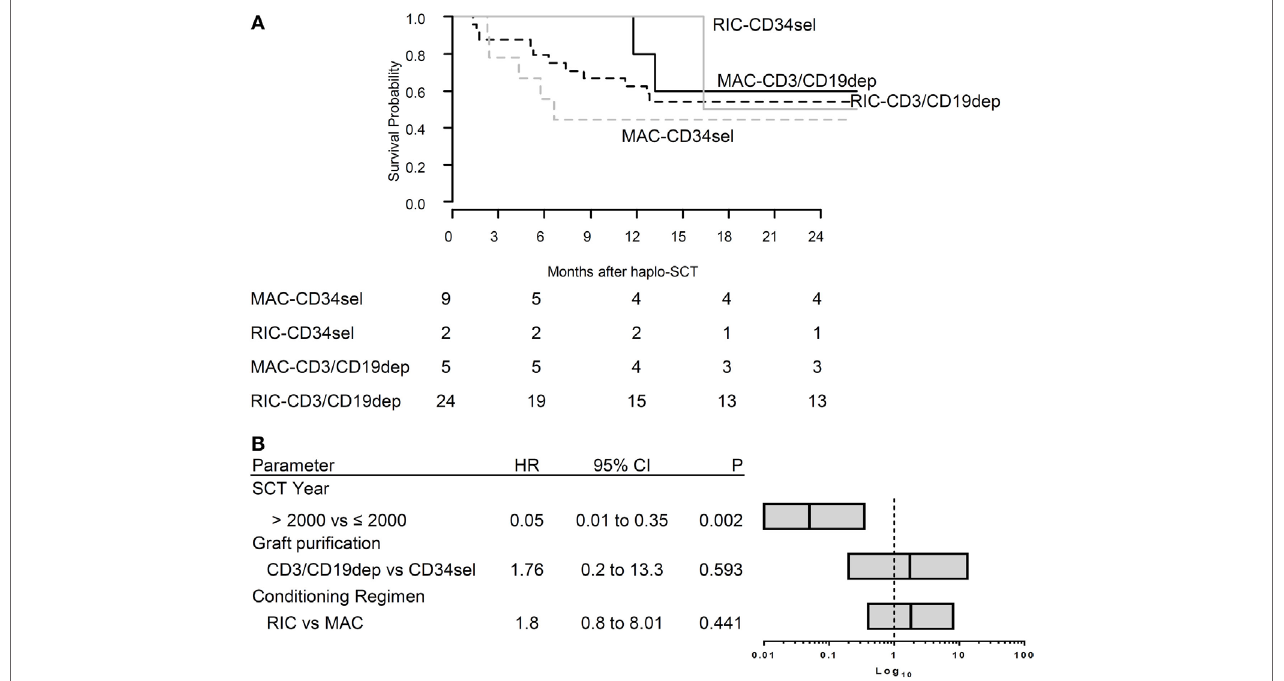
FigUre 3 | (a) Survival overall survival (OS). The Kaplan–Meier curve of OS for CR patients according to type of graft (CD34sel, CD3/CD19dep) combined with conditioning regimen (MAC, RIC). (b) Multivariable analysis of clinical characteristics affecting OS. The plot shows the hazard ratio (HR) of multivariable Cox regression. The stem cell transplantation year was significant correlated with OS. The bar in each box represents the HR, the box the corresponding 95% confidence interval. The vertical line represents HR = 1 for reference.